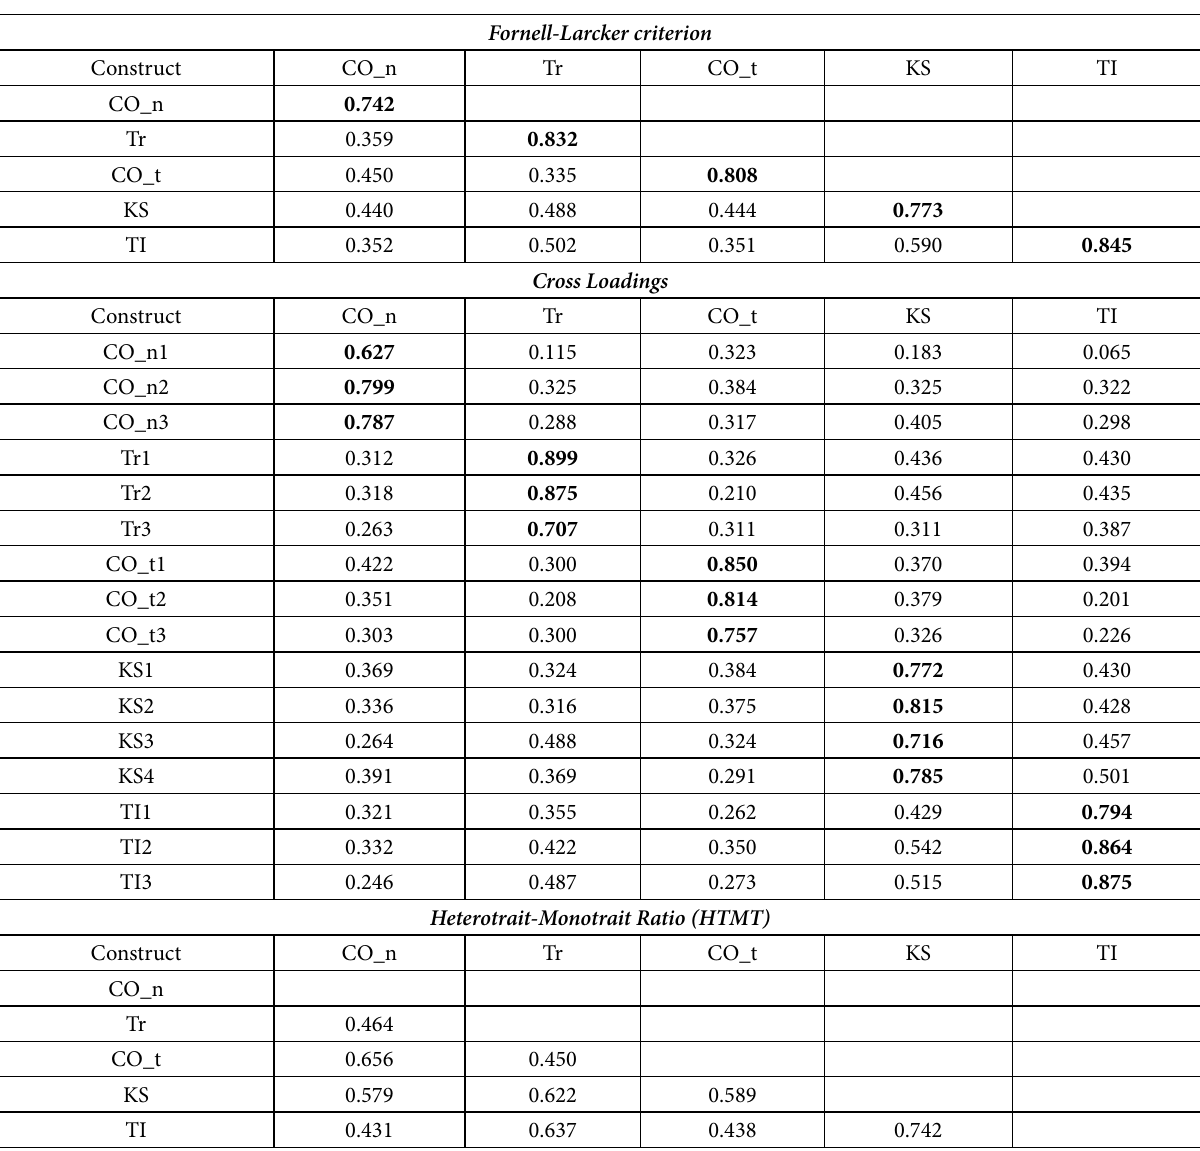
Table 5. Discriminant